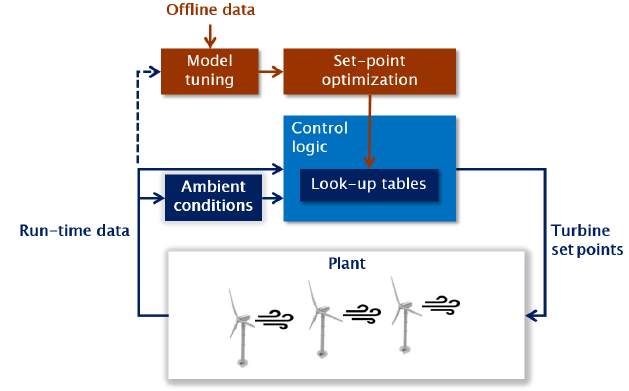
Figure 5. Wind farm control scheme. The option to update the model at runtime to recompile the LUTs (dashed line) was not used in the present